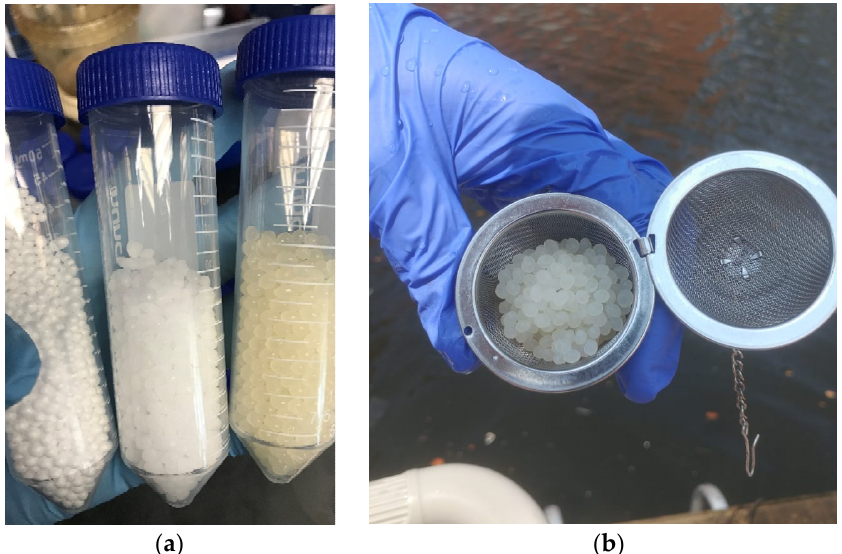
Figure 1. ( a ) Microplastic beads composed of polystyrene, polypropylene, and polylactic acid, re- spectively. ( b ) Stainless steel mesh container with polylactic acid microbeads. respectively. ( b ) Stainless steel mesh container with polylactic acid